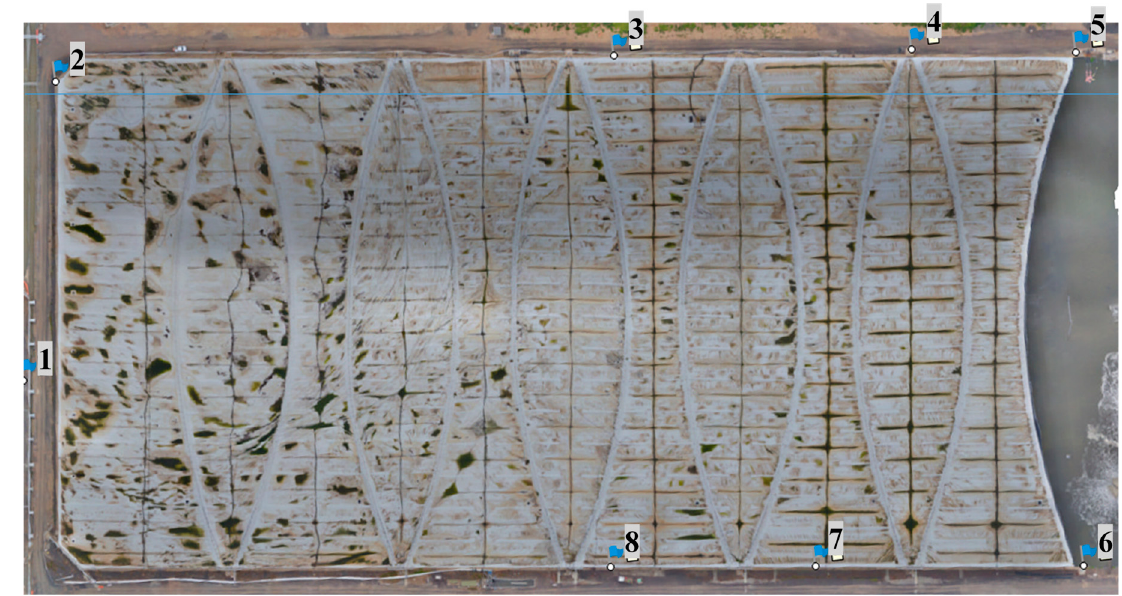
Figure 3. Orthophoto of the covered anaerobic lagoon (CAL) at WTP with GCPs. Table 1. Flight parameters and Photogrammetry configurations for the UAV surveillances over the lagoon cover at